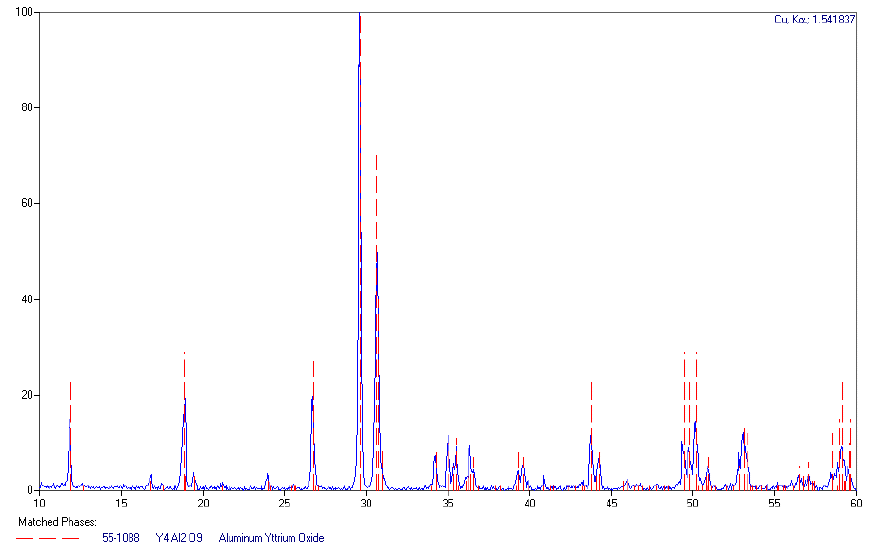
Figure 1. The XRD spectrum of an undoped YAM sample (blue line) and Y 4 Al 2 O 9 features from the database (red dashed lines).